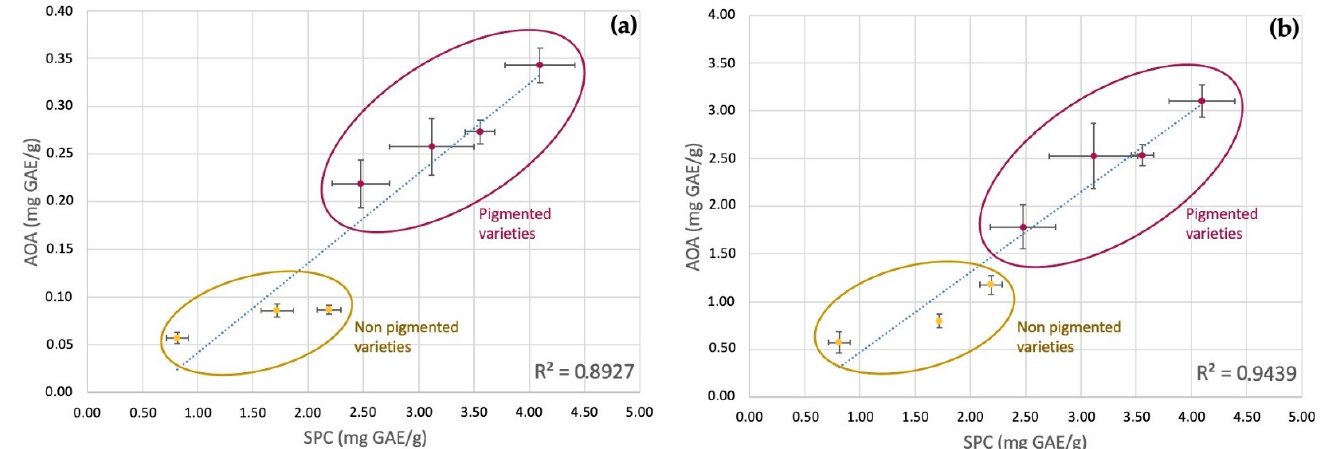
Figure 3. Correlation between soluble phenolic content (SPC) and the antioxidant activity (AOA) measured with: ( a ) DPPH and ( b ) TEAC assays.